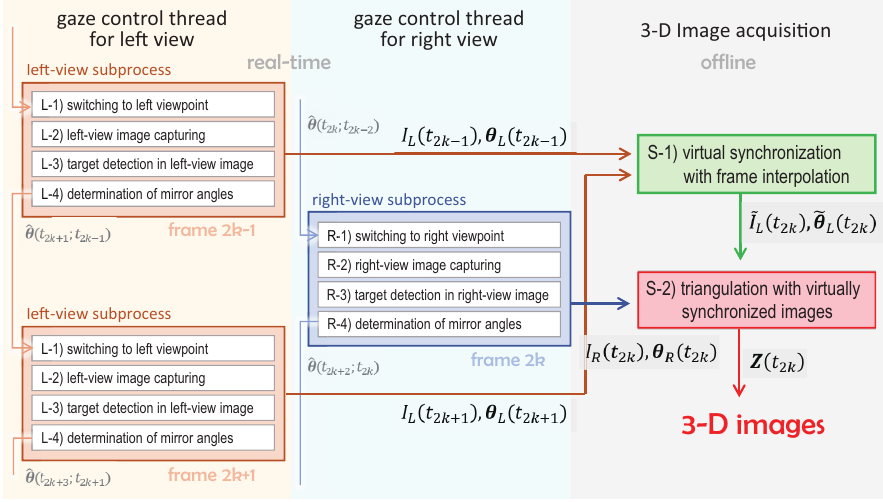
Figure 9. Flowchart of the implemented